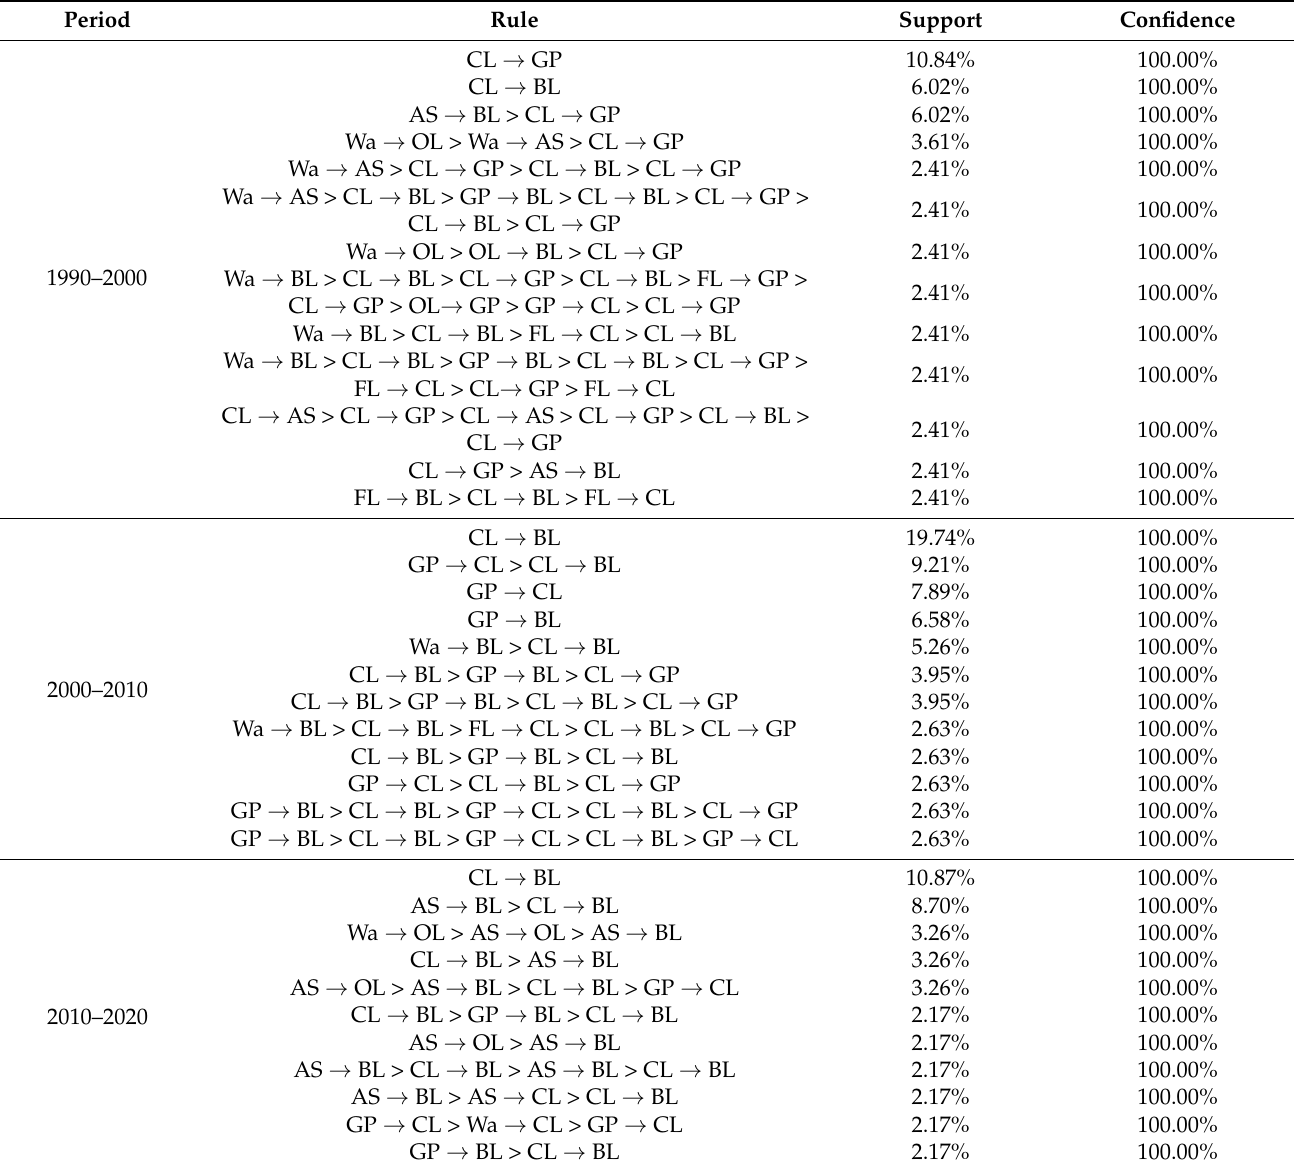
Table 4. LUT association rules in the Qingdao